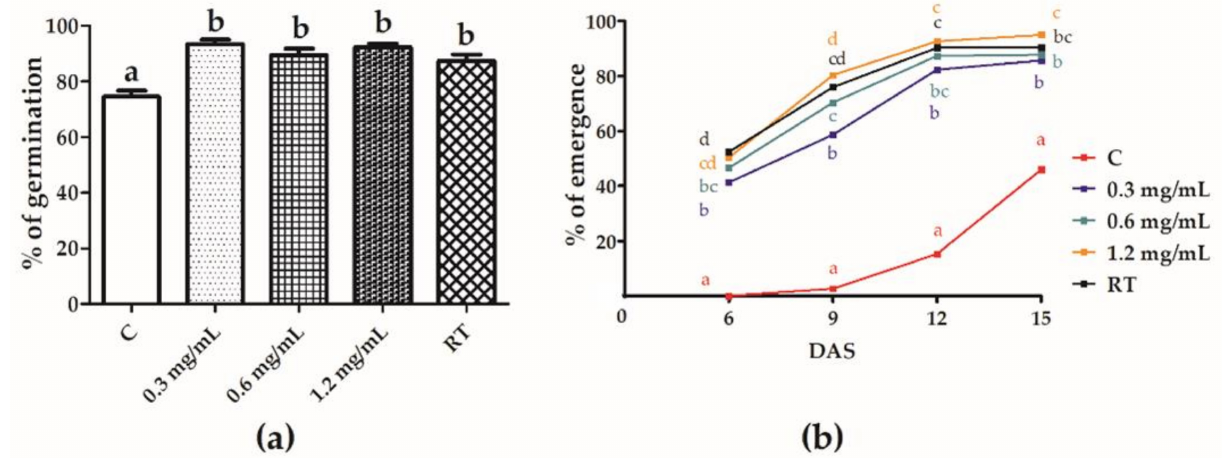
Figure 2. Preliminary assays on the effect of tomato seed treatment with different concentrations (0.3, 0.6, and 1.2 mg/mL) of Jania adhaerens water-soluble polysaccharides on the seed germination percentage in blotting paper test ( a ) and on the percentage of seedling emergence in the experiment under greenhouse conditions ( b ). C = water control; RT = reference treatment (2 mL/L); DAS = days after sowing. In panel ( a ), columns are mean values of 3 independent experiments ( n = 3) ± SD. Different letters indicate significant differences among treatments and control according to the LSD test ( p < 0.05). In panel ( b ), each value is the mean of 3 independent experiments ( n = 3); different letters indicate significant differences among treatments and the control within each DAS, according to the LSD test ( p <